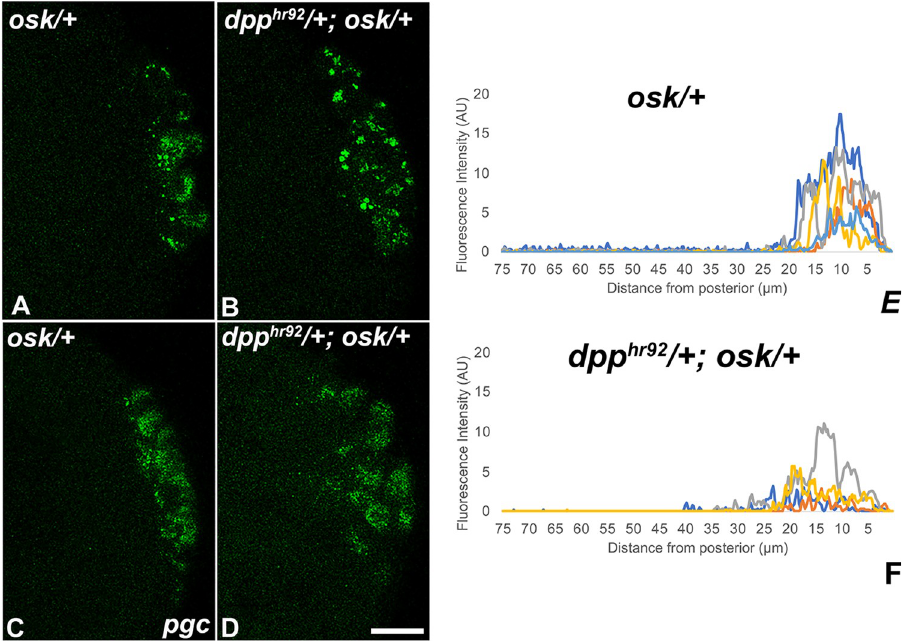
Fig 9. Simultaneously compromising maternal and zygotic levels of oskar and dpp respectively results in aberrant localization of germ plasm. smFISH was performed using probes specific for pgc (green) on 0–4 hr paraformaldehyde-fixed (A/C) osk/+ and (B/D) dpp hr92 /+;osk/+ embryos to assess spread of pole plasm from the posterior. Images are representative maximum intensity projections Scale bar represents 10 μ m. (E-F) Plot profiles show mislocalization of pole plasm (visualized using pgc ) away from posterior cap (see Materials and Methods for details of quantification). Each plot shows a representative experiment, with each line depicting pole plasm distribution of an individual